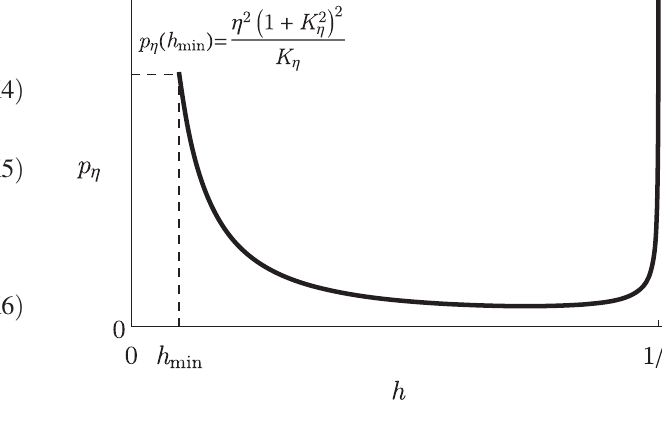
FIG. 18. Plot of the PDF of p η ð h ; 0 Þ ≡ p η ð h Þ given in Eq.